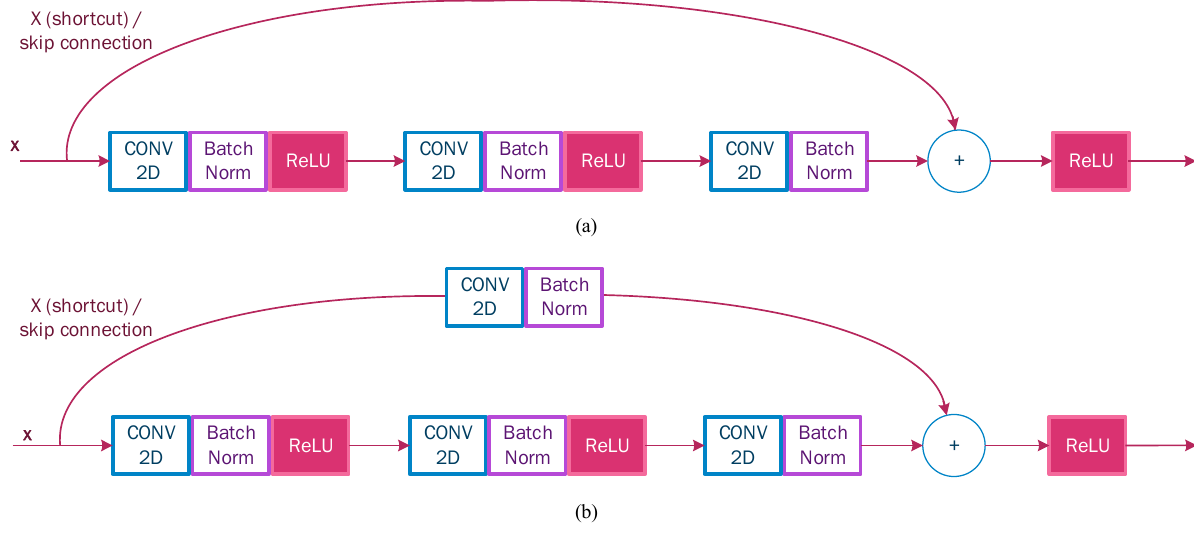
Figure 5. ( a ) ResNet identity block and ( b ) ResNet convolutional block.